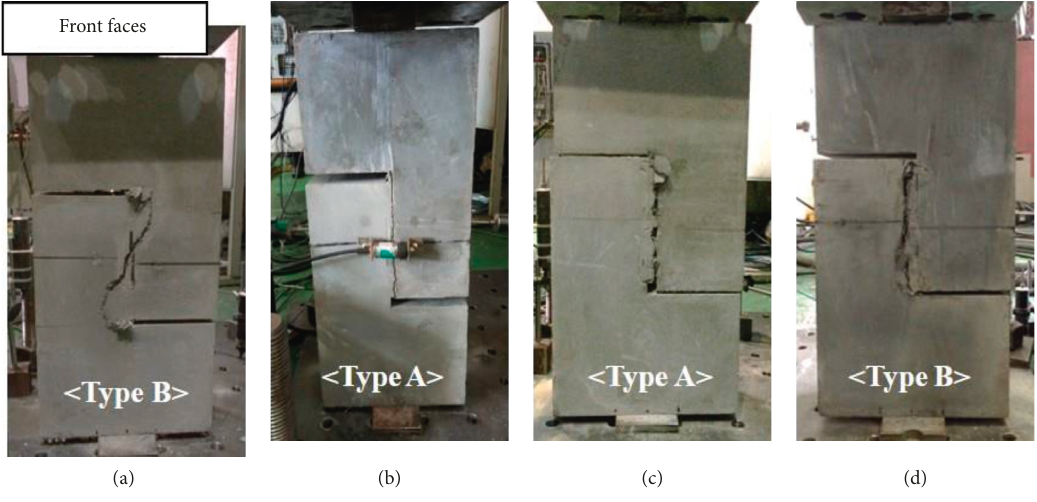
Figure 12: Failure modes: (a) MN-0; (b) VC-0; (c) GR-20; (d) GR-30.